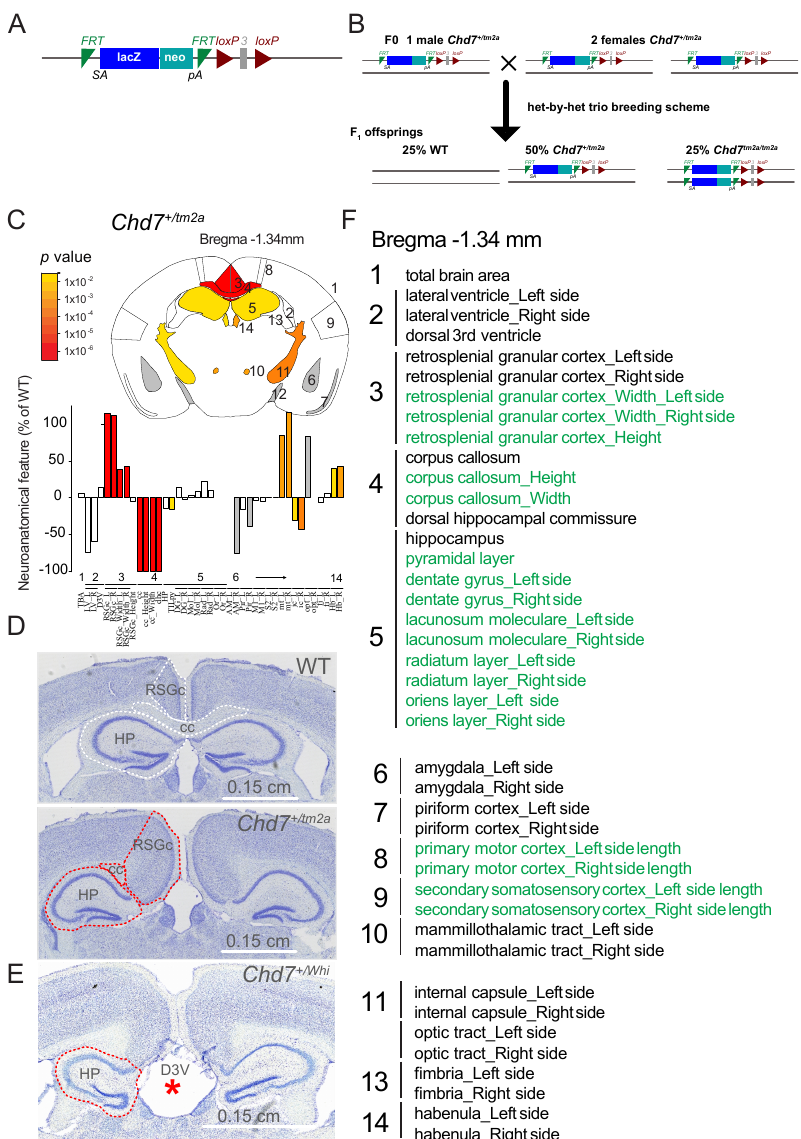
Figure 1. Chd7 male mice exhibit major defects in midline crossing and fiber tracts. ( A ) Allelic construction of the Chd7 tm2a mouse model. ( B ) Breeding strategy used in the Chd7 tm2a mouse study. ( C ) The image shows a schematic representation of affected brain regions in Chd7 +/tm2a male mice at 16weeks of age plotted in the coronal plane (section at Bregma—1.34mm) and colored according to p values on the side. Gray indicates parameters which could not be confidently tested (n too low to calculate the statistics). The name of each brain region numbered in ( C ) is given in panel ( F ). Histograms show neuroanatomical features as the percentage decrease (minus scale) or increase (plus scale) of the measured brain regions in Chd7 +/tm2a mutant mice compared with matched controls. ( D ) Representative coronal brain sections of Chd7 +/tm2a male mice and matched controls double- stained with Nissl and Luxol fast blue. Brain regions of interest are highlighted by white and red dashed lines in controls and mutants, respectively. ( E ) On a coronal plane at Bregma—1.34 mm, Chd7 +/Whi mice show enlarged ventricles (indicated by a red asterisk), hippocampus dysgenesis (indicated by red dashed lines) and failure of midline crossing, albeit only in one sample, the other two appearing normal. ( F ) Details of brain regions assessed in order of appearance in panels ( C ) together with corresponding numbers. Green is for lengths and black is for areas. Retrosplenial granular cortex: RGCs, Hippocampus: HP, Dorsal third ventricle: D3V, Corpus callosum: